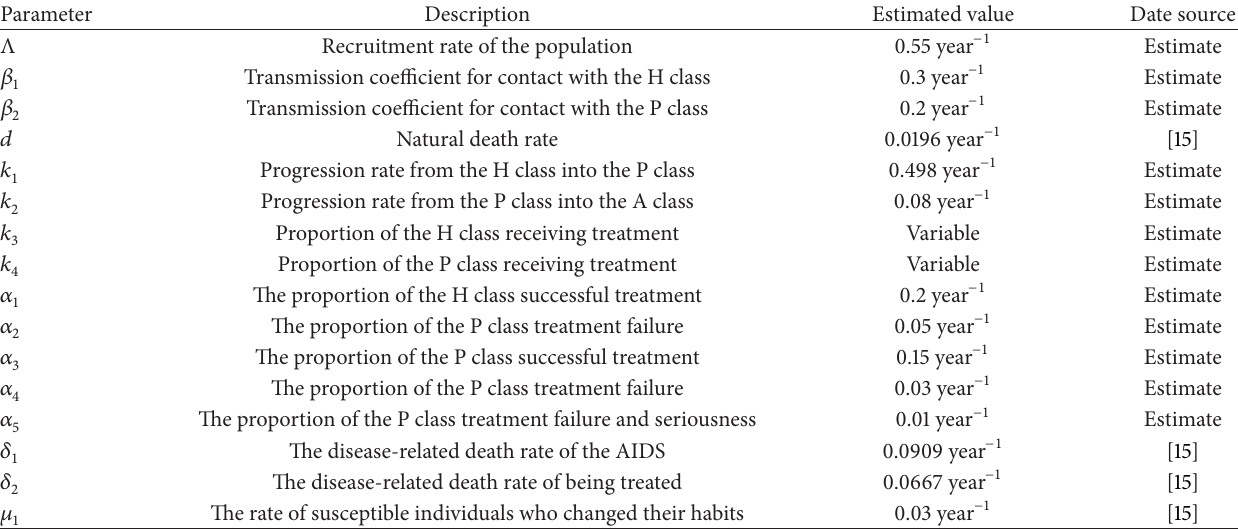
Figure 1: Transfer diagram of the model (2). Table 1: Description and estimation of